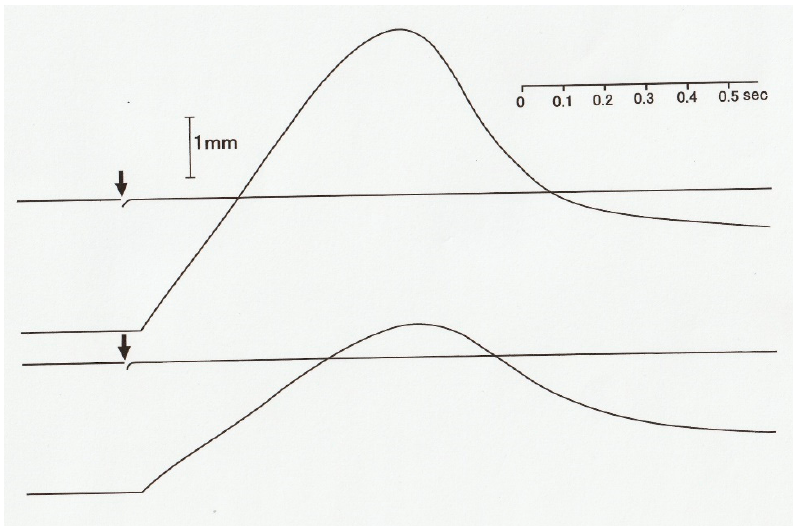
Figure 8. Records of fiber length (upper traces) and force (lower traces) of experiments in which the tetanized intact muscle fiber was first made to shorten isotonically under a load 0.8 Po and, after 50ms, subjected to quick increases in load from 0.8 Po to 0.85 Po in ( A ) , to 0.9 Po in ( B ), to 1.1 Po in ( C ), and to 1.3 Po in ( D ). Note marked changes in fiber length with alternate lengthening and shortening in A , B , and C . From Ref. [12].